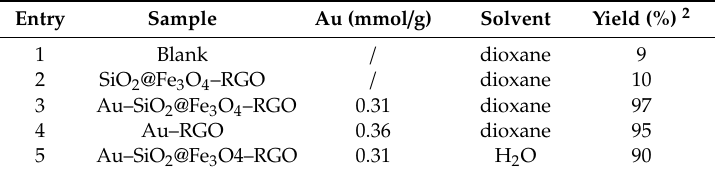
Table 1. Catalytic e ffi ciencies towards the hydration of phenylacetylene 1 .